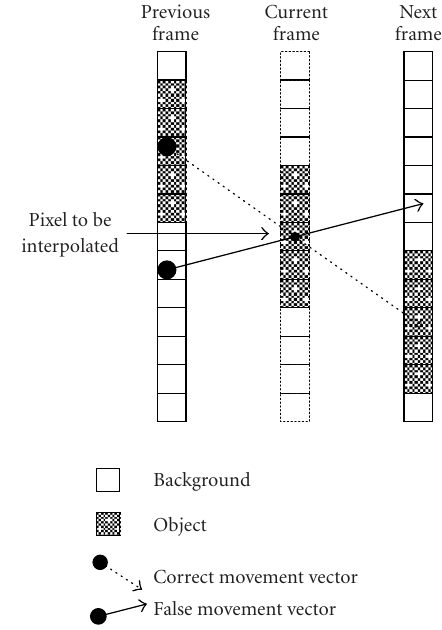
Figure 6: Problem with false